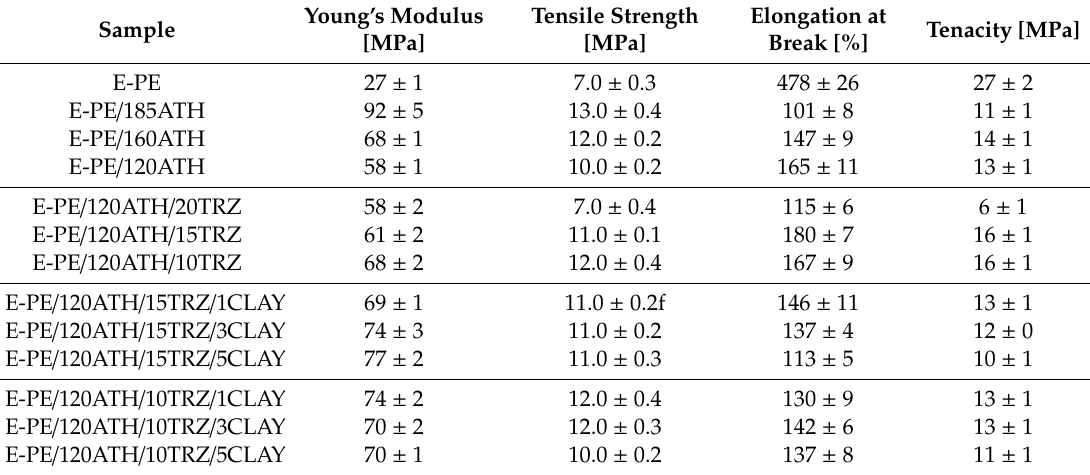
Table 5. Mechanical properties of E-PE blend and corresponding